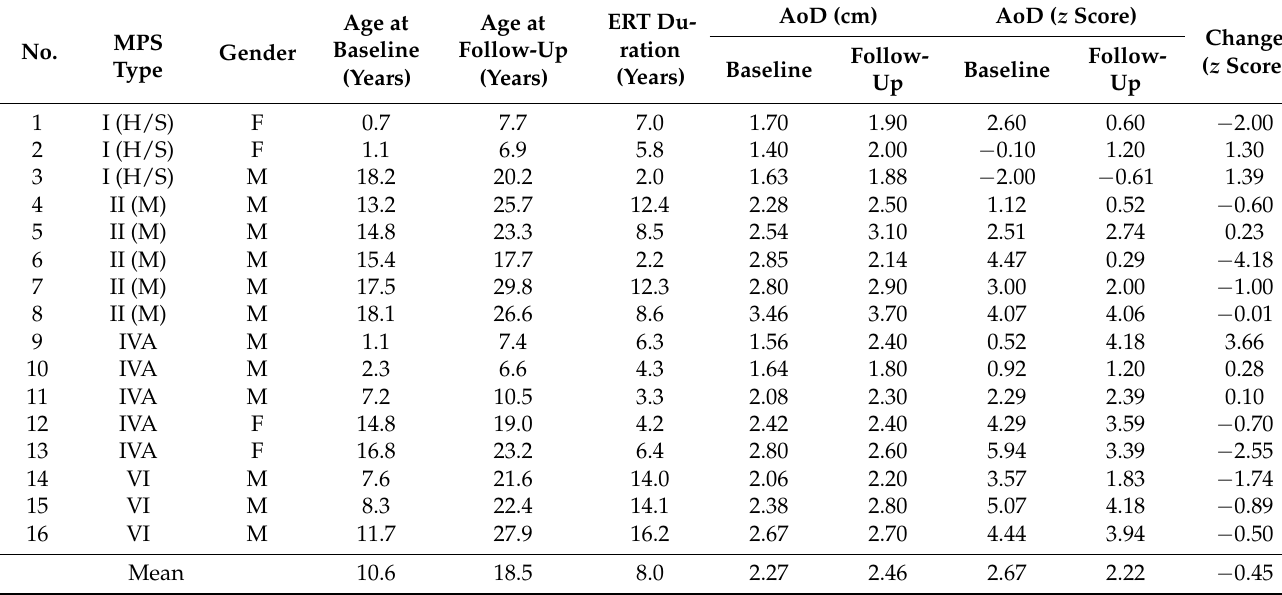
Table 3. Baseline and follow-up data of aortic root diameter of 16 patients with MPS who received enzyme replacement therapy for 2.0–16.2